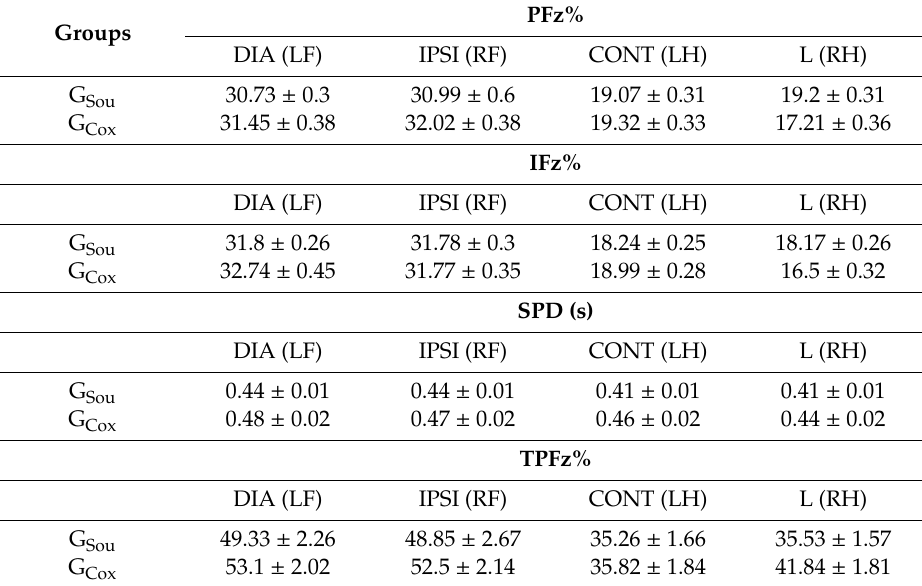
Table 2. Mean values ± standard deviation of the PFz%, IFz%, SPD (s), and TPFz% in the IPSI / RF, DIA / LF, CONT / LH, and L / RH limbs from dogs of G Sou and G Cox